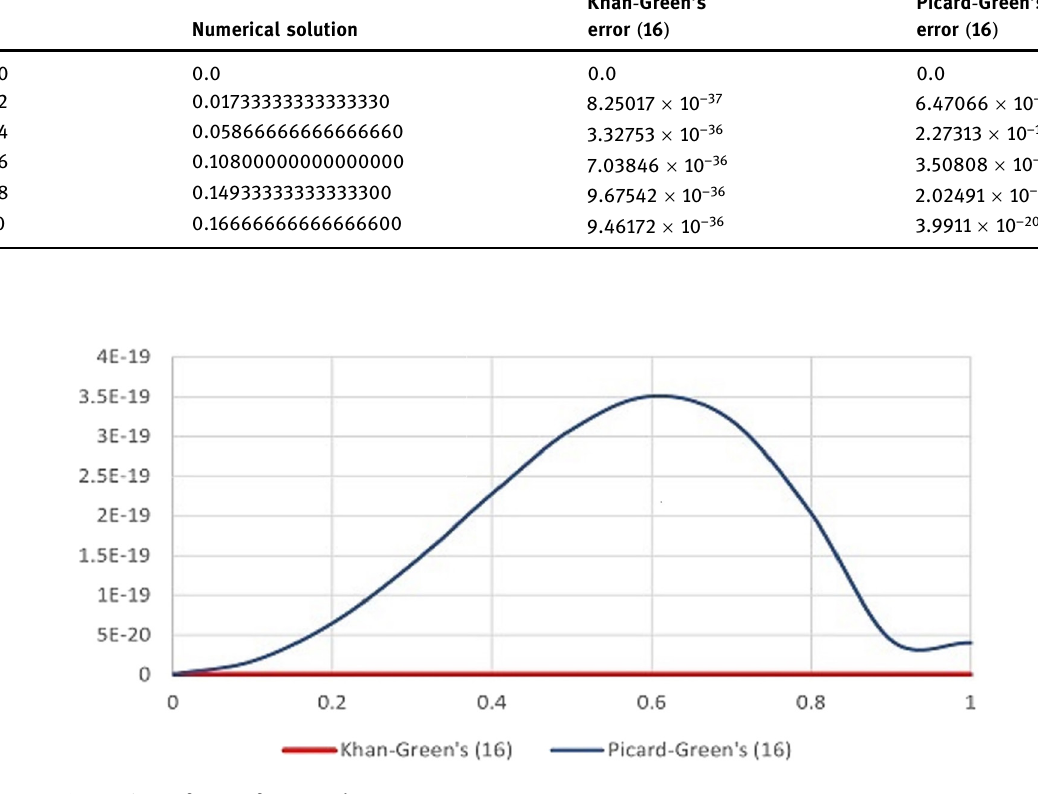
Figure 2: Comparison of errors for Example